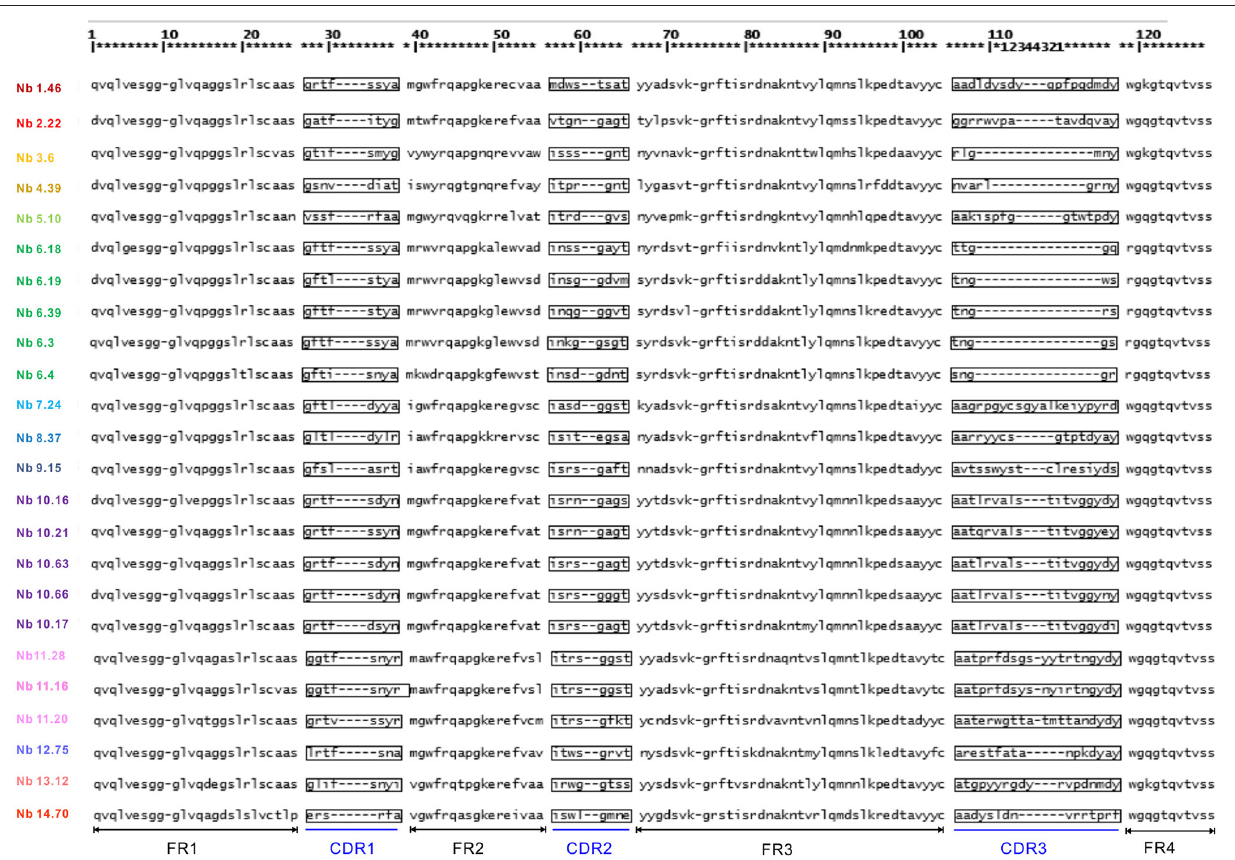
of Nb 1.46, 12.75, and 5.10 from the Clec4F conjugated SRP